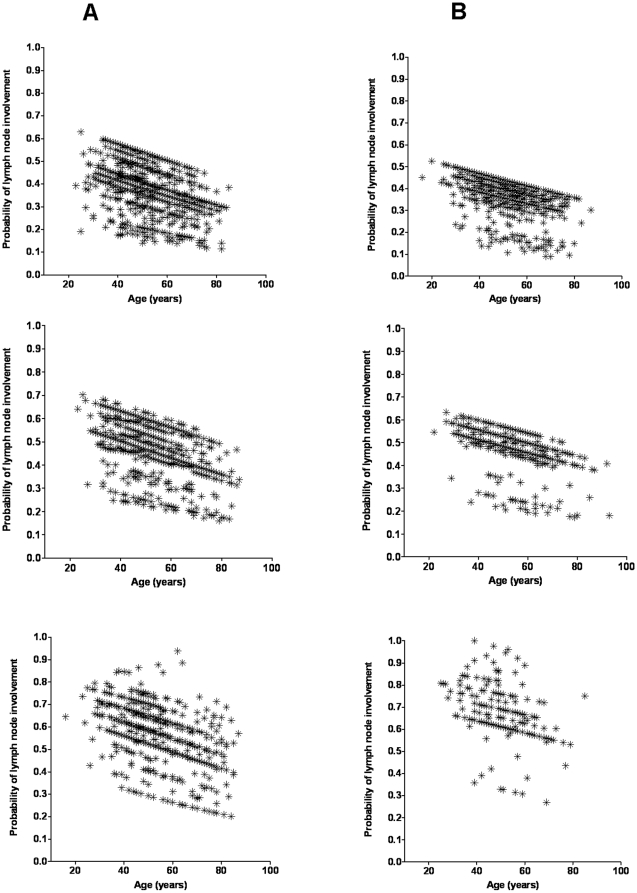
Scatterplots of age and the model's predicted probability of lymph node involvement.These patients have complete data on age at diagnosis, tumor size, axillary lymph node status, and IHC-based subtypes. Separate plots are shown for (A) the first dataset (n = 3,715) and (B) the second dataset (n = 1,832), and for women with tumor size up to 2.0 cm (top plots), tumor size between 2.1 and 3.5 cm (middle plots), and tumor size greater than 3.5 cm (bottom plots).